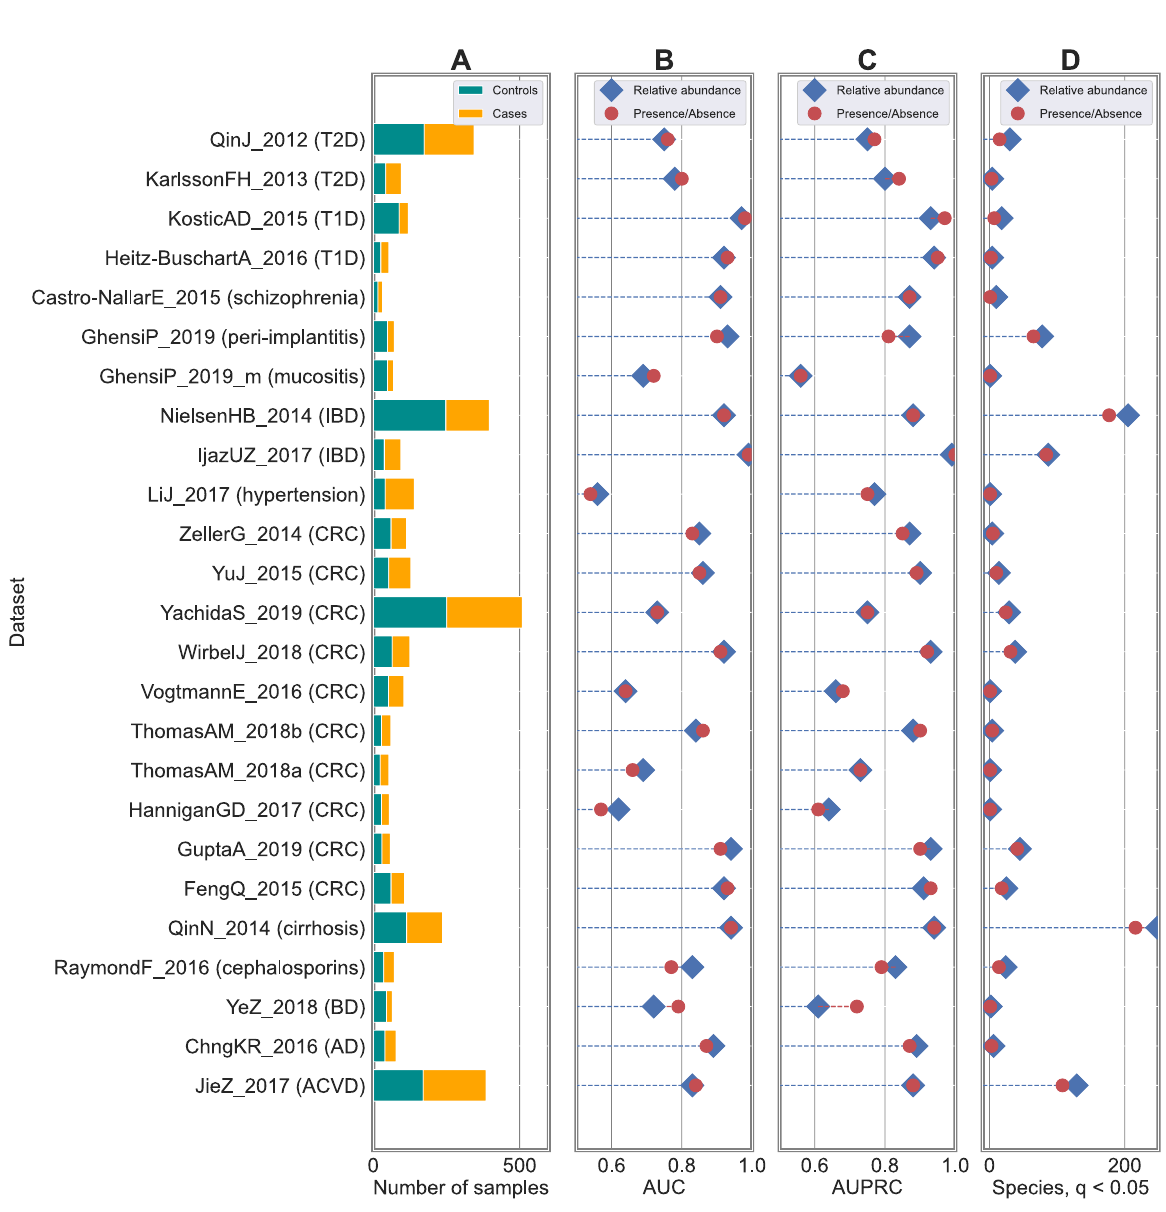
Fig 1. Classification accuracies are robust to degradation from species-level relative abundance to presence/absence profiles in shotgun datasets. Results obtained on 25 case-control studies for host phenotype classification from human microbiomes. ( A ) Number of case and control samples across the different studies. ( B ) AUC and ( C ) AUPRC scores using RF as back-end classifiers on species-level taxonomic profiles. Comparison between relative abundance (in blue) and presence/absence (in red) profiles highlighted negligible differences and no statistical differences in none of the studies (see S1 Fig for AUC scores and S2 Table for p-values). Metrics of comparison in terms of AUC, AUPRC, precision, recall, and F1 are summarized in S2 Fig and S2 Table is represented a comparison between AUC and AUPCR scores. ( D ) Number of statistically significant taxa from relative abundance (in blue) and presence/absence (in red)